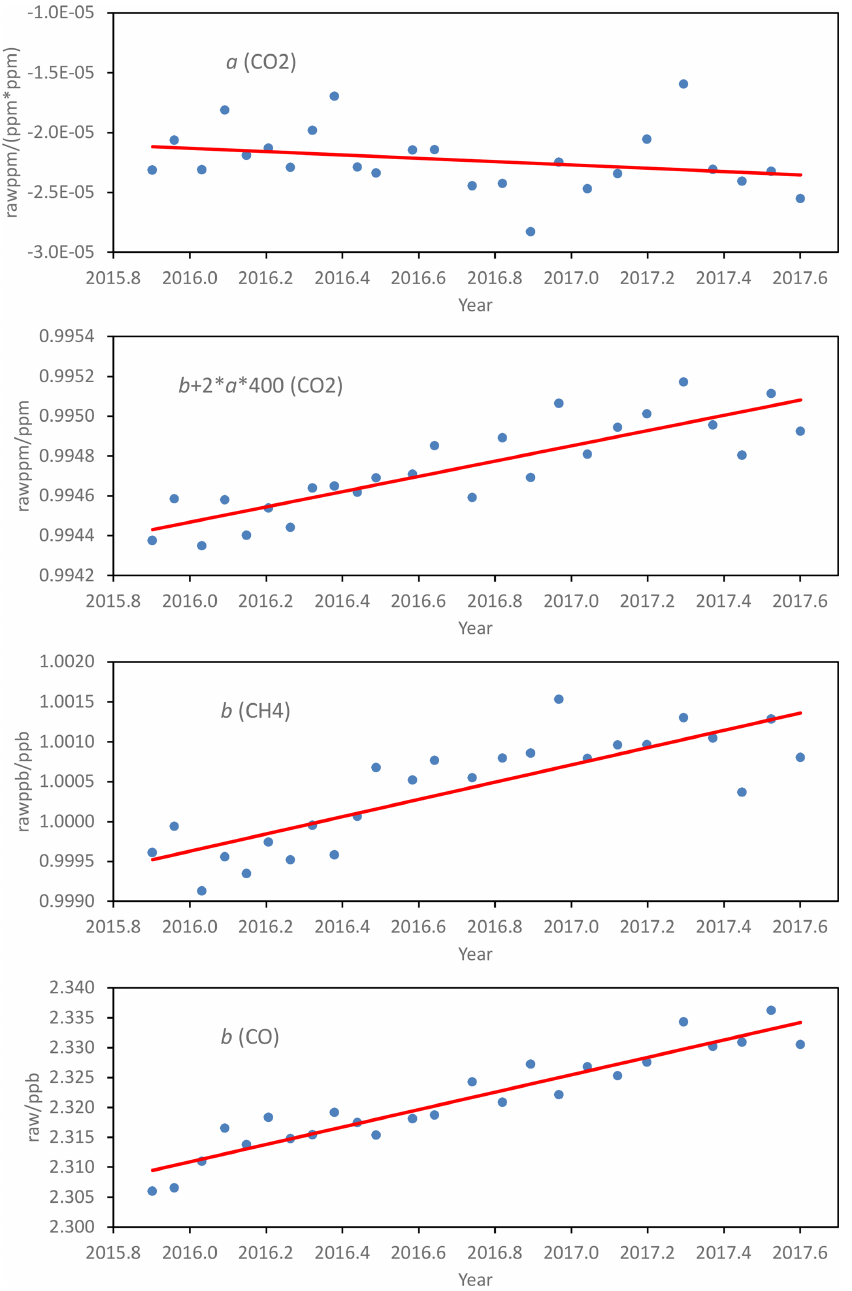
Figure 6. Quadratic coefficient of the CO 2 response function ( a ) and local slope of the response function at the mole fraction of the virtual tank, for CO 2 , CH 4 , and CO. Note that for CH 4 and CO, the local slope does not depend on the mole fraction and is equal to the coefficient b . The red line corresponds to a least-square fitting of the data to a linear